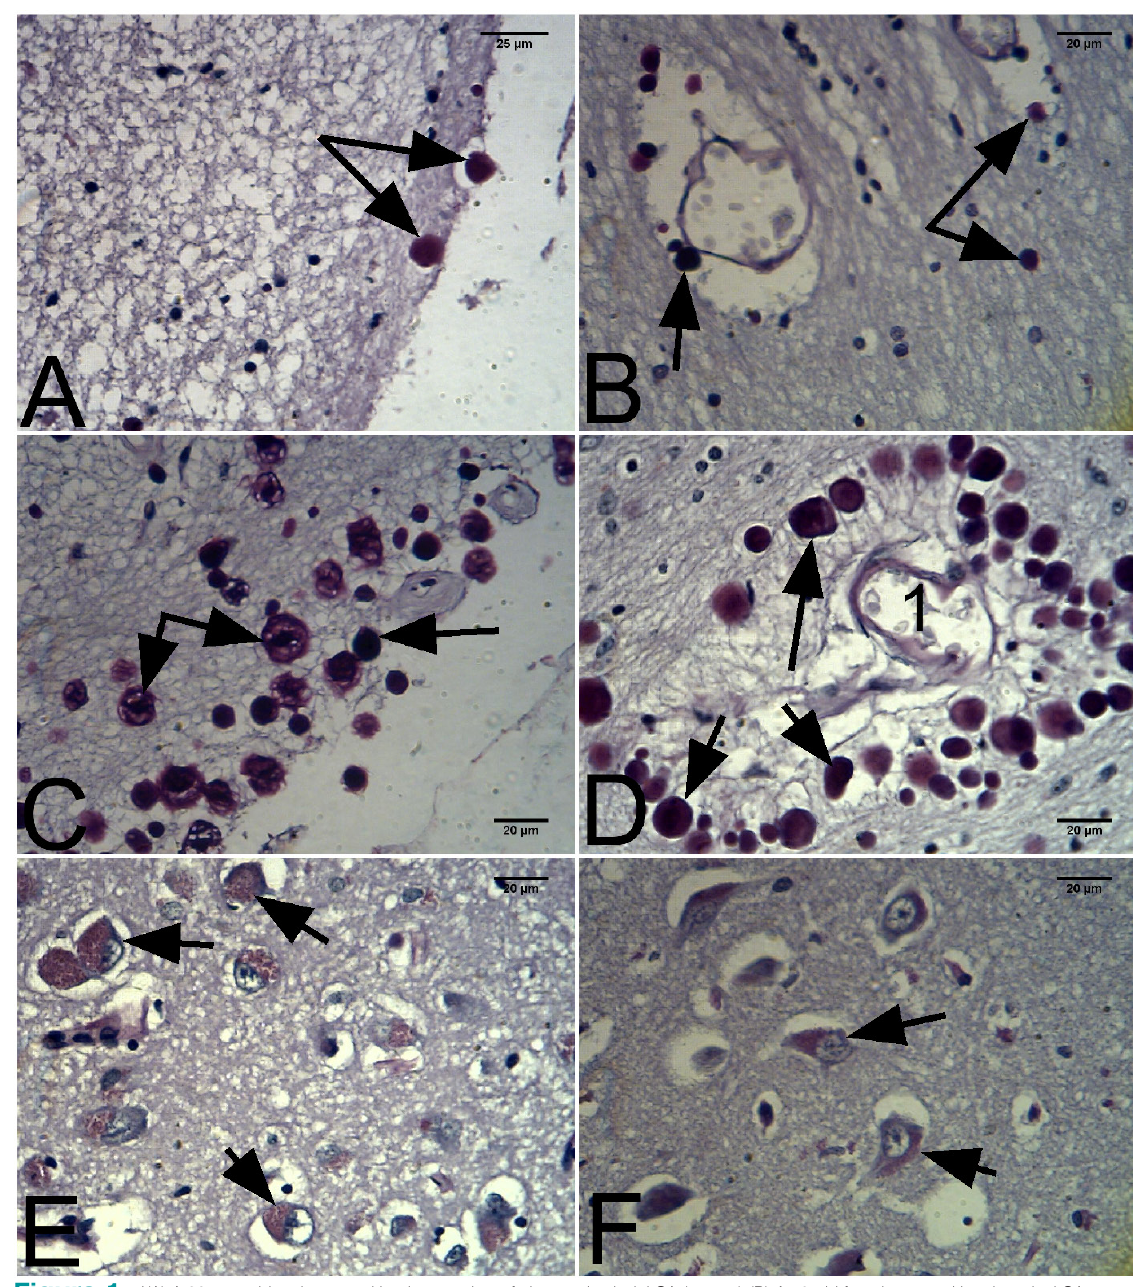
Figure 1. I(A) A 26-year-old male case with a low number of observed subpial CA (arrows) (B) A 50-old female case with subcortical CA (arrows) (C) An 84-year-old male case with the yeast form of subpial CA (arrows) (D) A 70-year=old female case with subcortical CA (arrows); 1 – subcortical blood vessel (E) Neurons with significant lipofuscin inclusions of a 78-yearold male case (arrows) (F) A 65-year-old female case with less frequent lipofuscin-positive neurons and smaller lipofuscin deposits in their perikarya (arrows); AB PAS; 40x lens